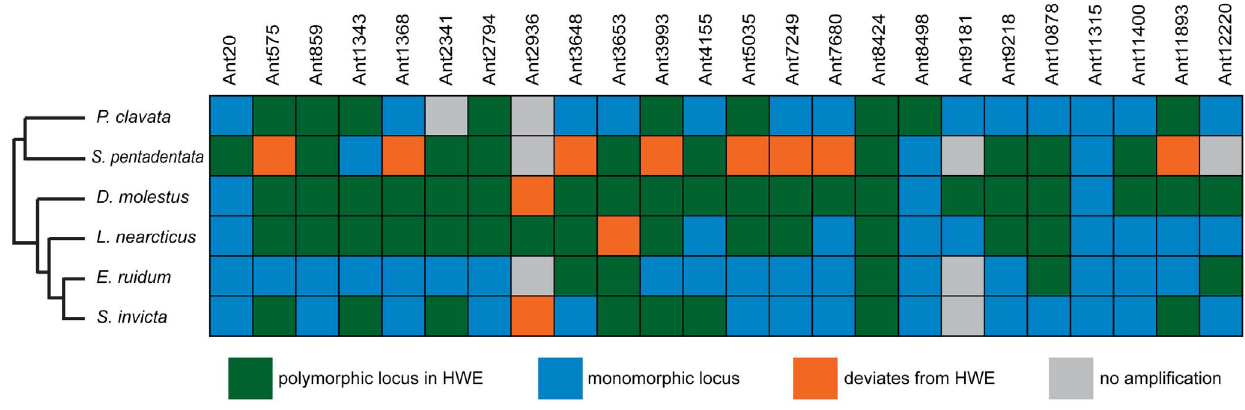
Figure 2. Overview results of genotyping 24 microsatellite loci for six different ant species. Green indicates loci that were polymorphic and in Hardy-Weinberg equilibrium, blue indicates monomorphic loci, orange indicates loci that were polymorphic but deviated from Hardy- Weinberg equilibrium, and grey indicates loci that did not amplify. The phylogeny to the left of the figure shows the evolutionary relationships of the species tested.